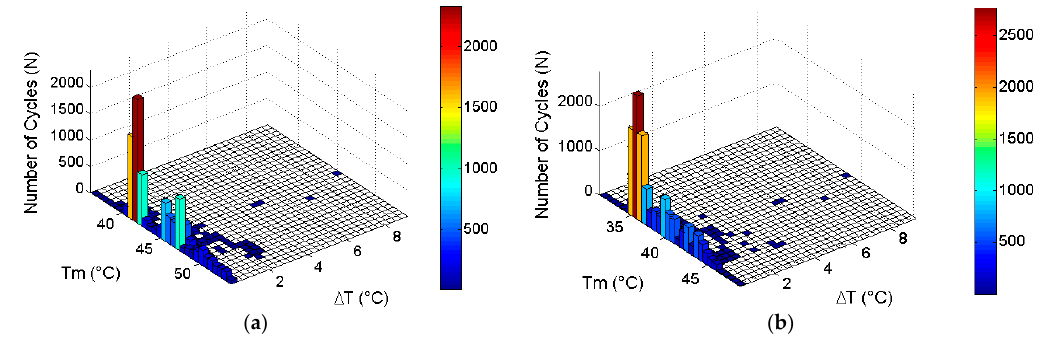
Figure 22. Number of cycles found with ( a ) IC and ( b ) P&O algorithms.